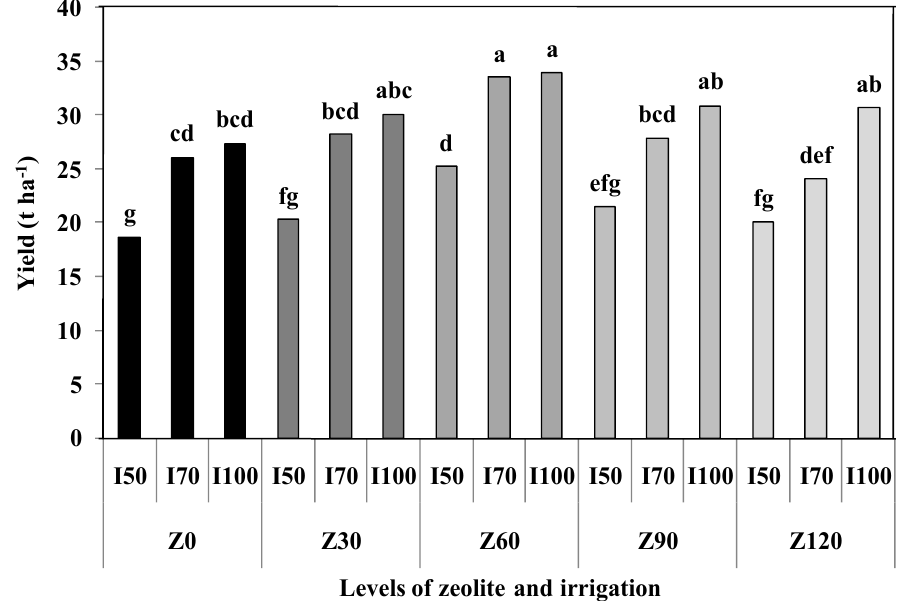
Figure 16. Effect of Zeolite Rates Eighth Different Levels of Irrigation on Tuber Yield of Potato (Z 0 : 0; Z 30 : 30; Z 60 : 60; Z 90 : 90; Z 120 : 120 t ha —1 ) Within treatments, different letters indicate significant differences at p ≤ 0.05(otherwise statistically at par). (Adapted and modified from Ozbahce et al.